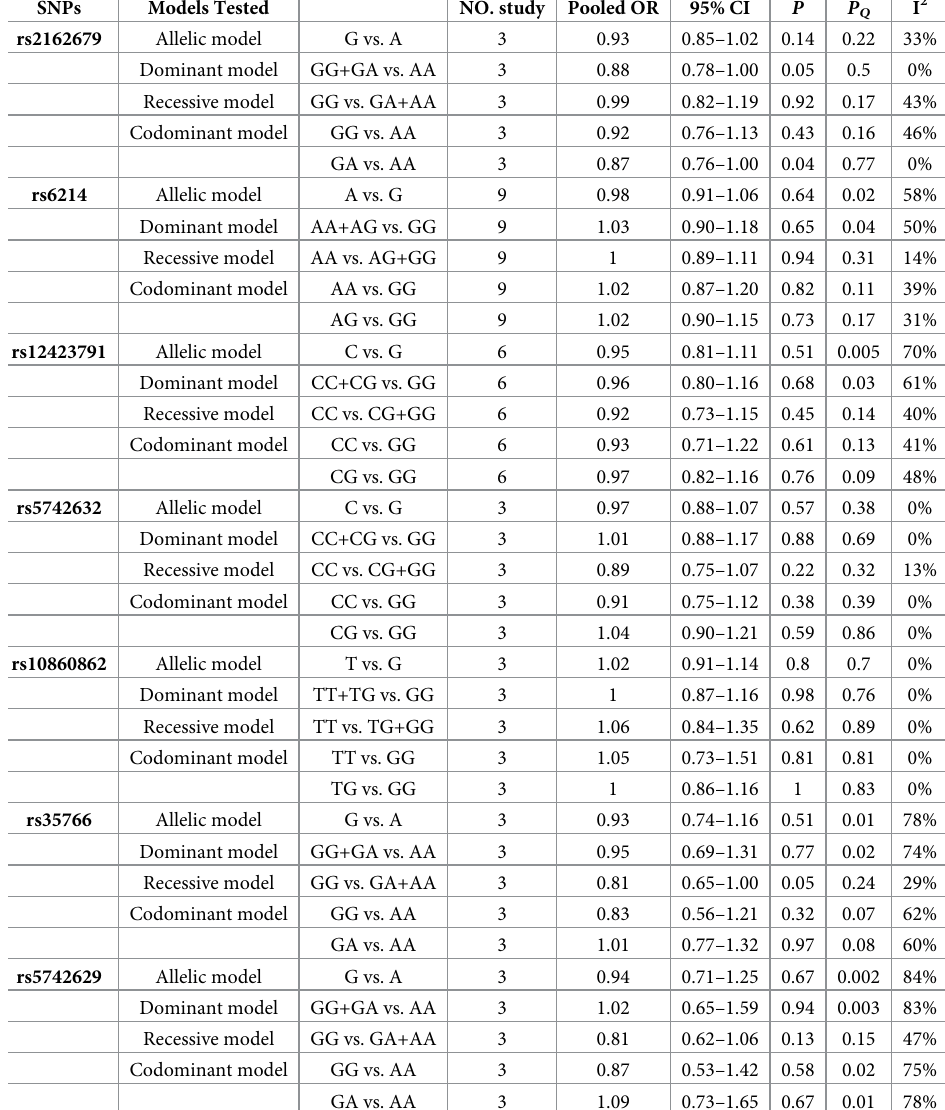
Table 2. Main results of the pooled ORs between IGF1 SNPs and any